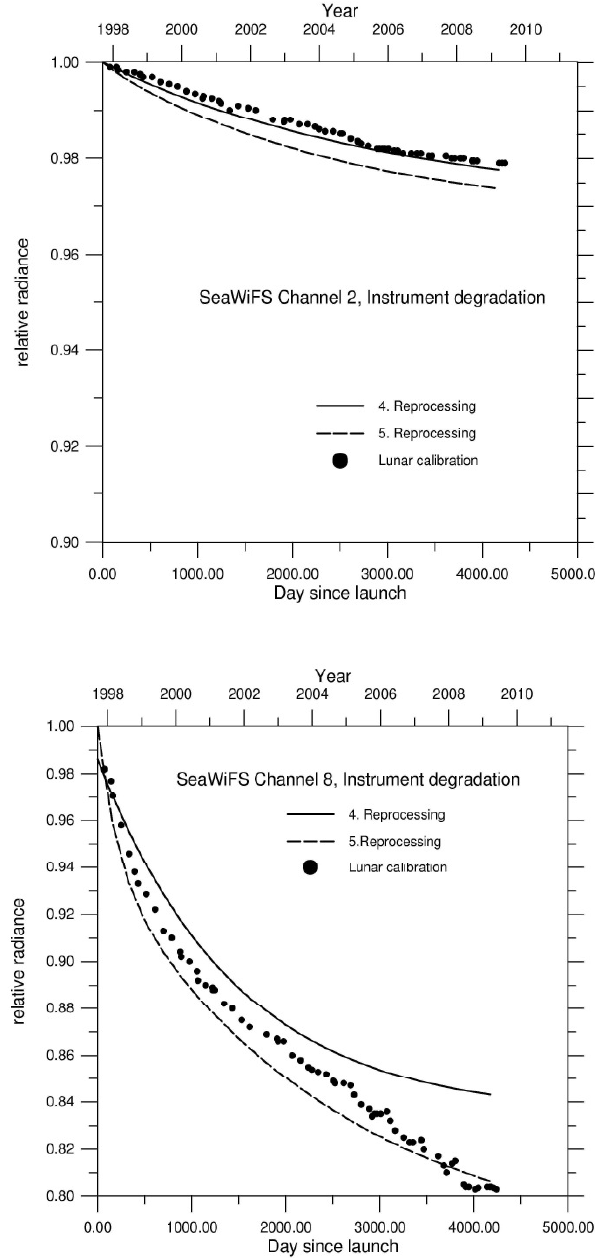
Fig. 19. Synthetic data retrieval. BAER retrieval results for two different phase functions: experimental LACE-98 and OPAC clean marine, using synthetic test data of Kokhanovsky et al. (2010). The dashed line is the plot of the synthetic test data.